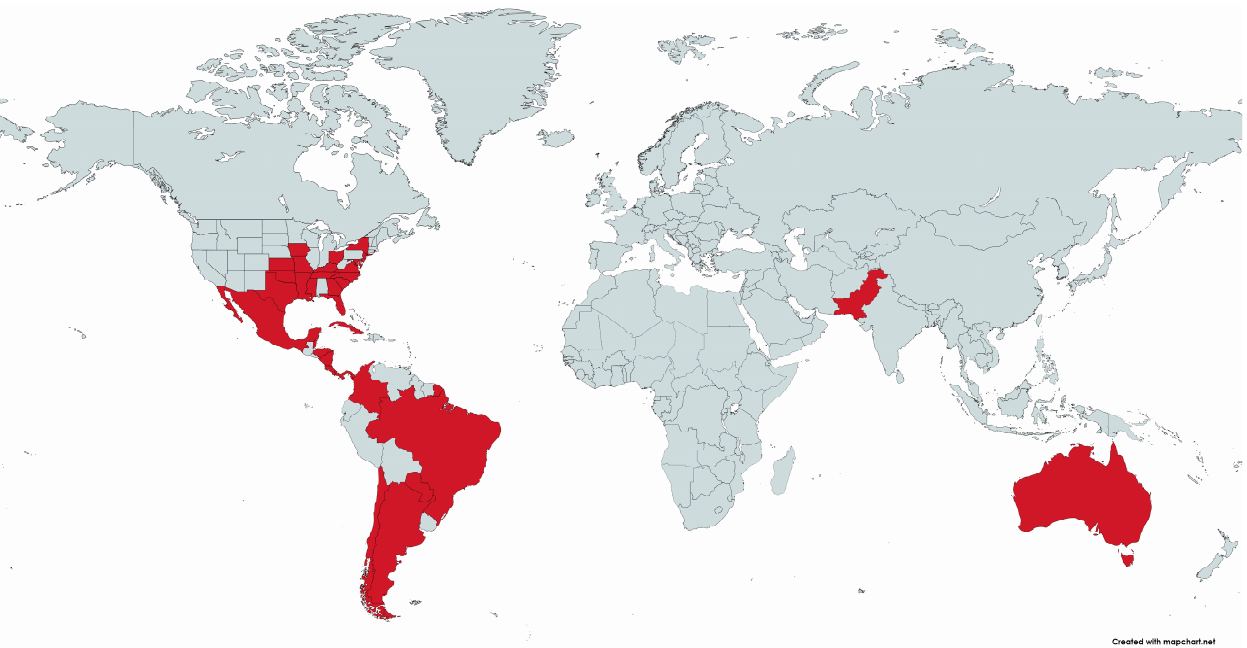
Figure 1. World map displaying the distribution of Rickettsia amblyommatis -infected ticks. Map created using www.mapchart.net (accessed on 27 January 2023).